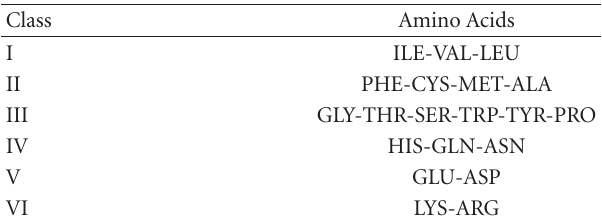
Table 3: Amino acids classes considered with respect to their hydropathy and charge. Every row shows the identification class and the amino acids